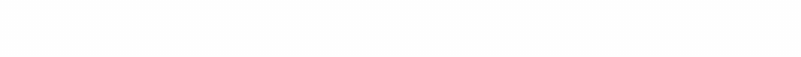
Table I. Graphical Explanation of Go-Back Adaptive